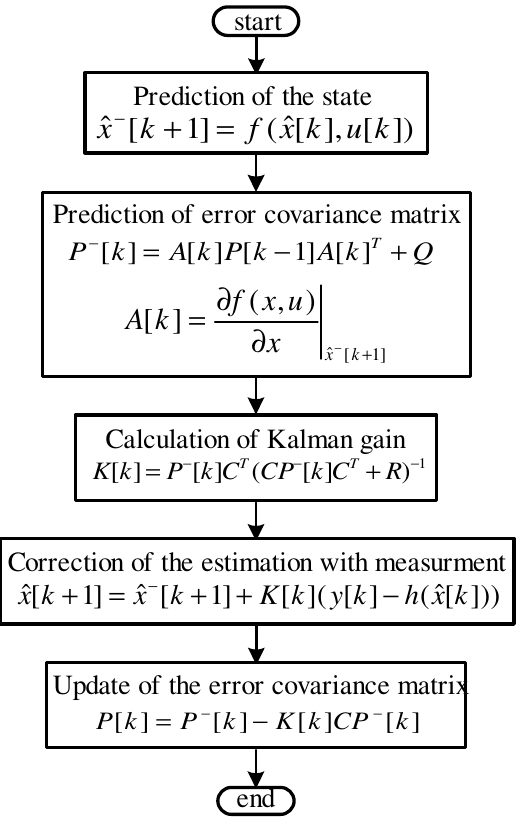
Figure 5. Flow chart of the extended Kalman filter.